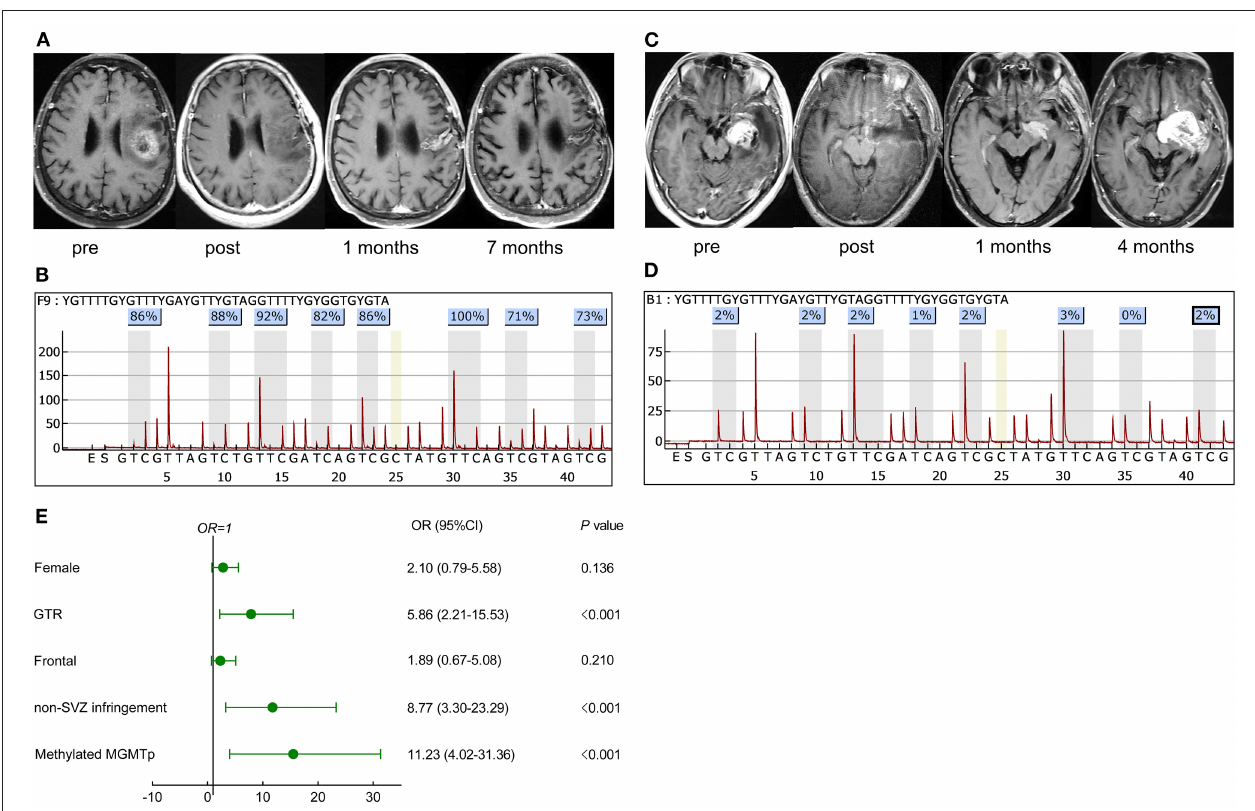
FIGURE 1 | Representative cases in pseudoprogression (PsP) and true early progression (TeP) and multivariate analysis for PsP in early progression patients. (A,C) A 72-year-old female patient with glioblastoma, isocitrate dehydrogenase (IDH) wild-type, presented a high methylated O-6-methylguanine-DNA methyltransferase (MGMT) promoter level [average 85%, (B) ]. The lesion that emerged 1 month after concurrent chemoradiation (CCRT) regressed spontaneously during the follow-up (A) . (C,D) A 39-year-old male patient was diagnosed with glioblastoma, IDH wild-type, and the average methylation level was 2% (D) . Postoperative magnetic resonance imaging (MRI) showed the tumor was totally removed. A new contrast-enhancing lesion appeared 1 month after CCRT and enlarged 3 months later, which was further pathologically confirmed as true recurrence. (E) Multivariate analysis demonstrated that GTR, non-SVZ infringement, methylated MGMTp were correlative factors leading to PsP. pre, preoperative MRI; post, postoperative MRI.